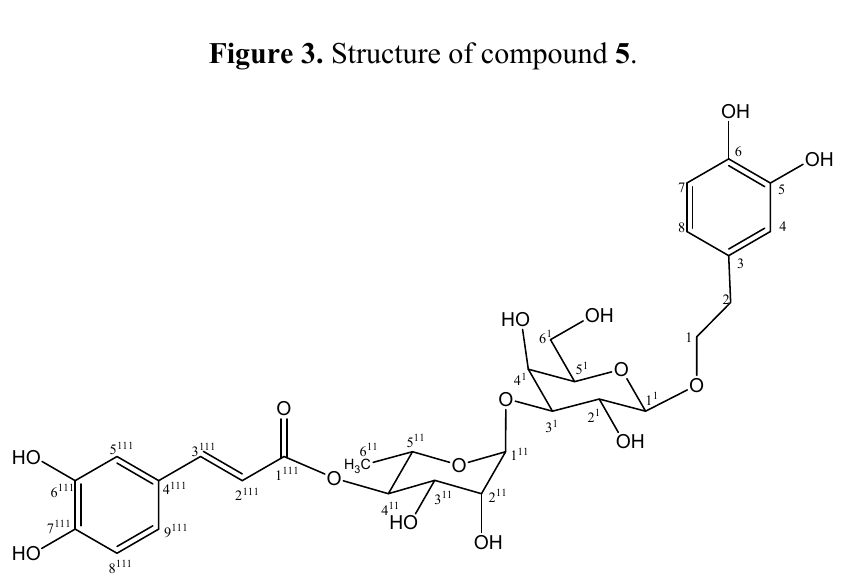
Figure 3. Structure of compound 5